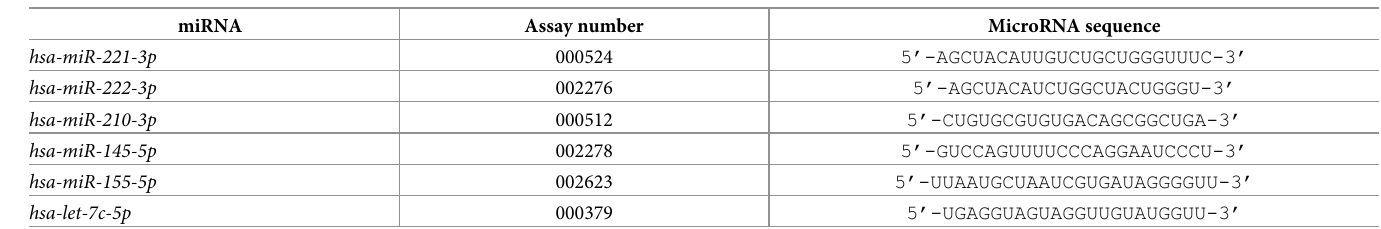
Table 2. Assays employed for miRNA quantification by RT-qPCR and RT-ddPCR.